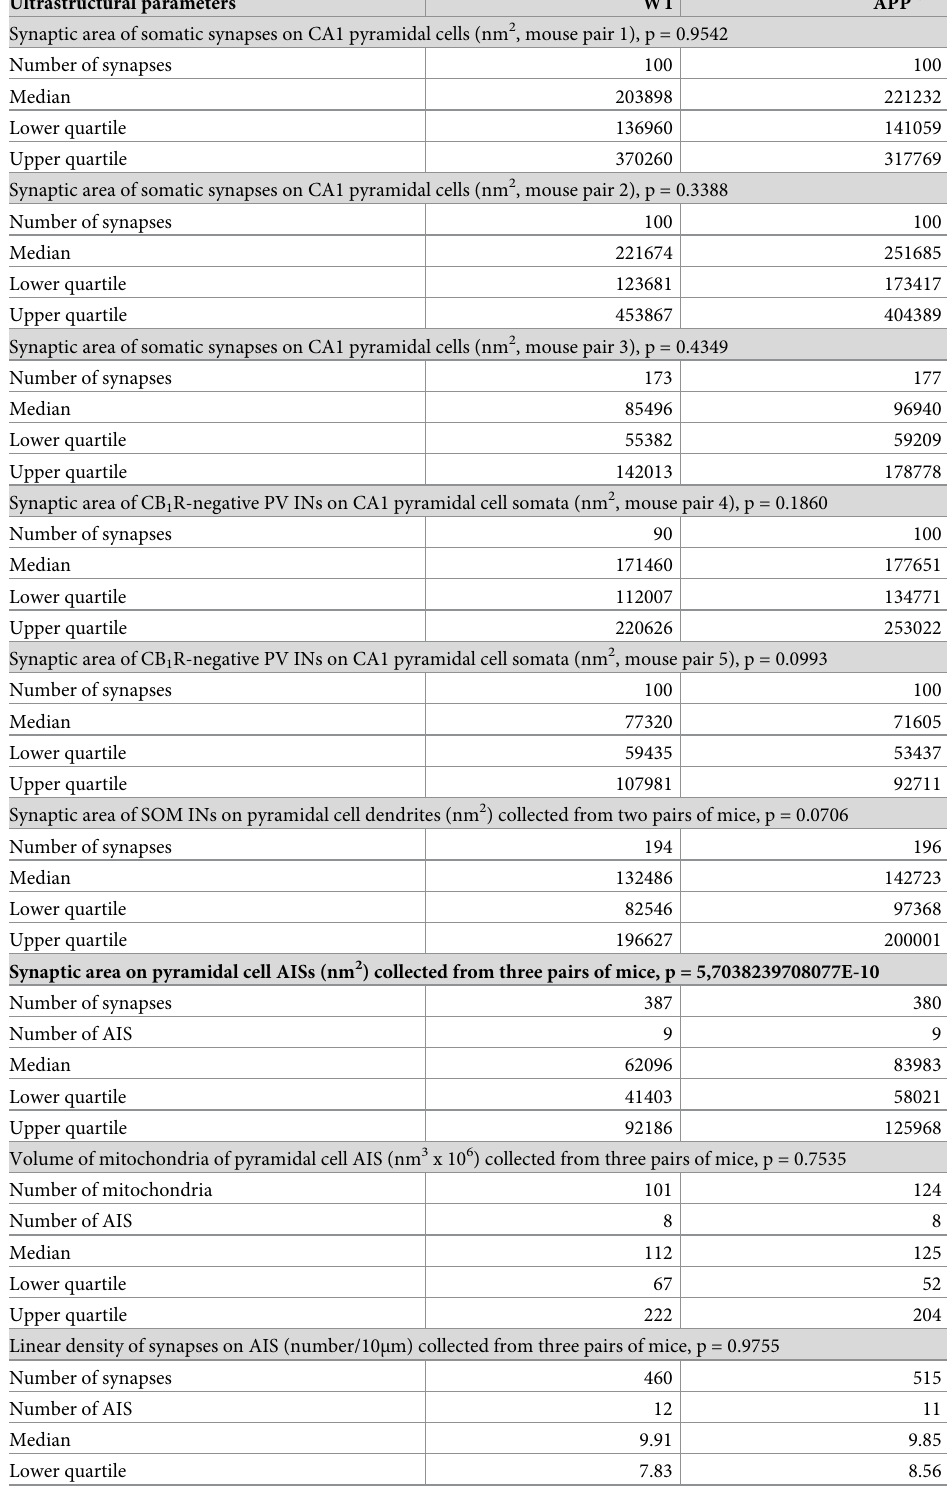
Table 3. Statistical data for BF-SEM